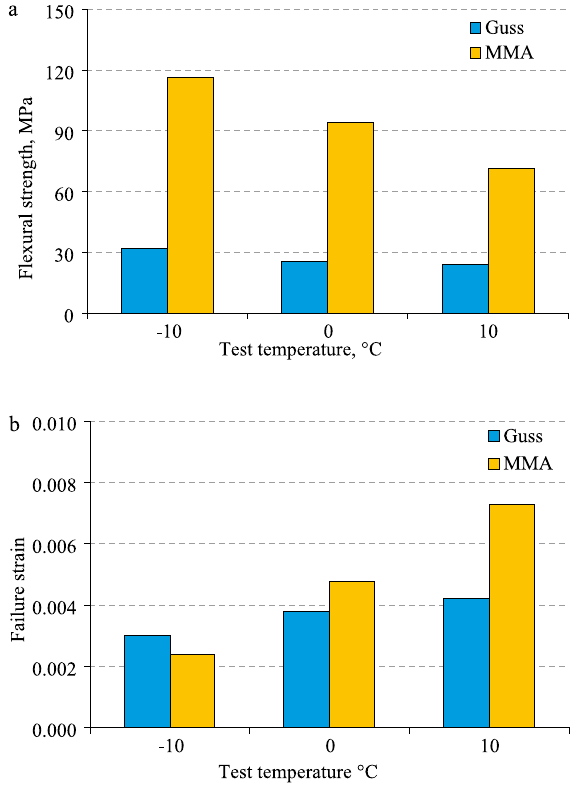
Fig. 6. Test results comparing MMA waterproofing materials with Guss asphalt mixtures: a – flexural strength at different test temperatures; b – failure strain at different test